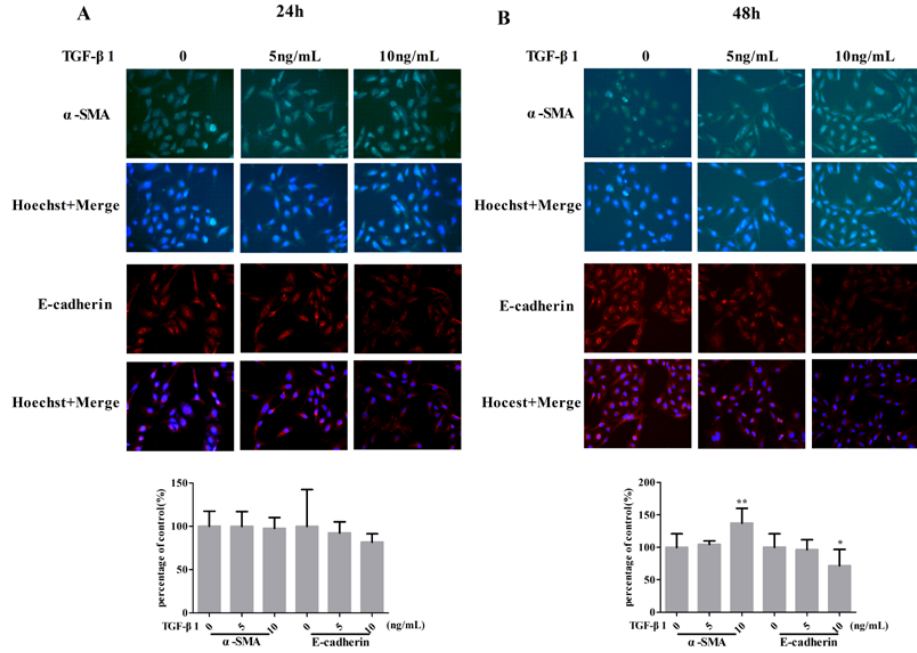
Figure 1. Expression of α -SMA and E-cadherin in HK-2 cells after stimulated by TGF- β1 in different concentrations for 24 h ( A ) and 48 h ( B ). The error bars represent standard deviation based on three repeated. All data was represented by Mean ± SD, ** p < 0.01 , * p < 0.05, n = 12 (single-trial).